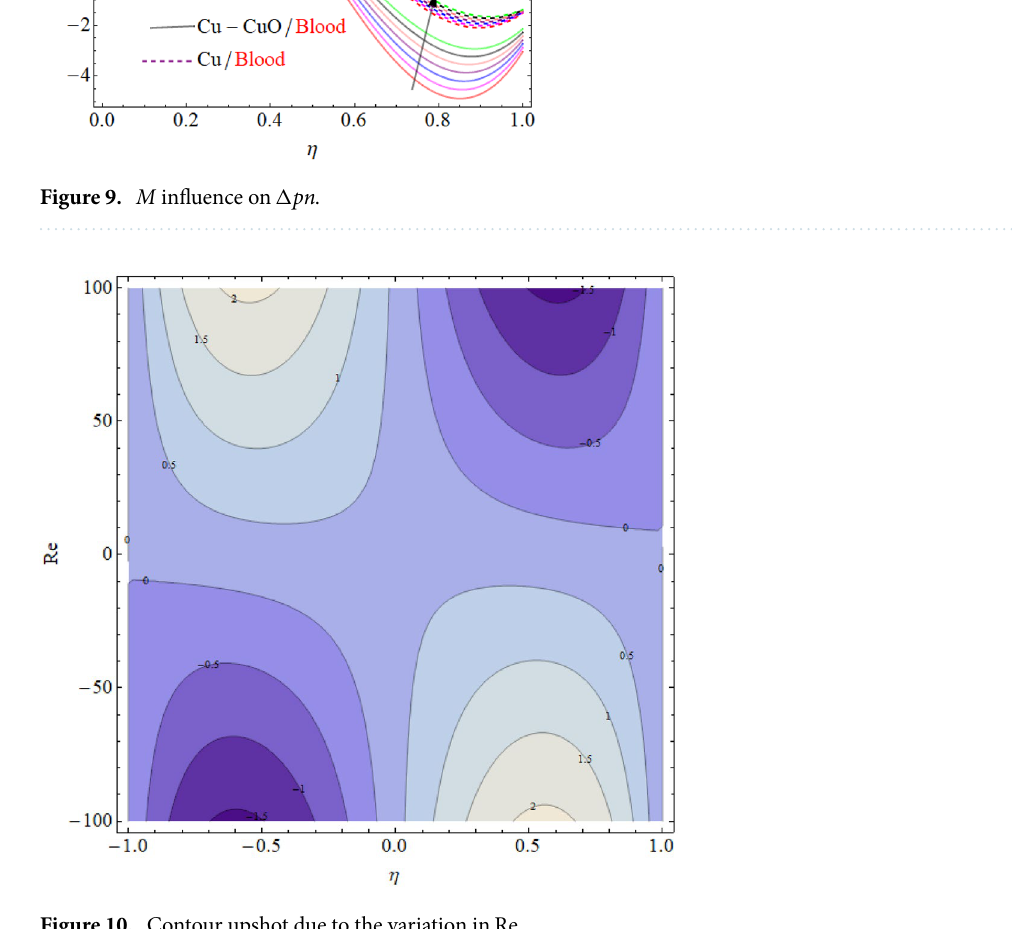
Figure 10. Contour upshot due to the variation in Re